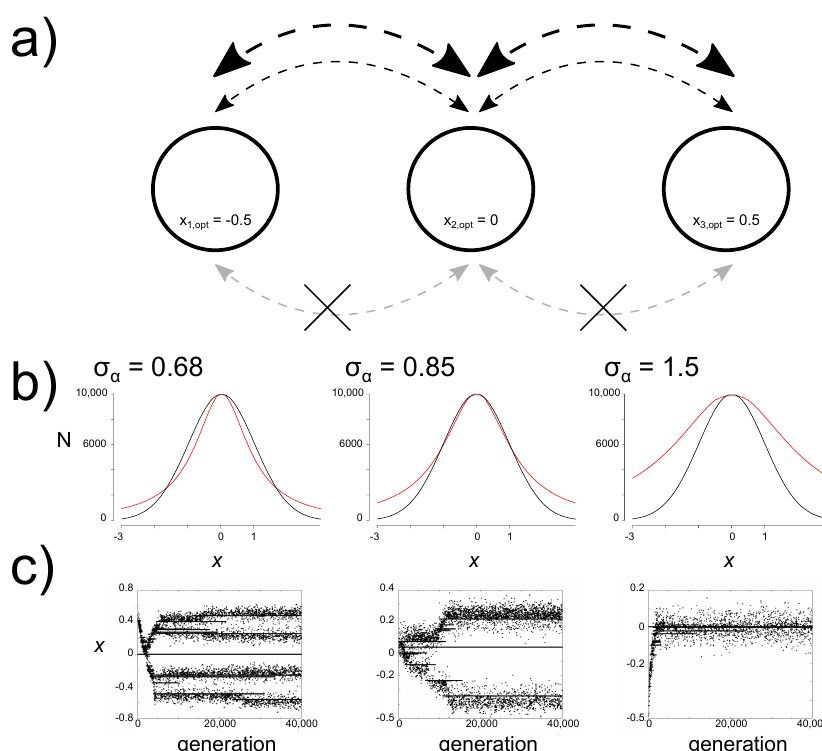
Figure 1. Model of metacommunity eco-evolutionary dynamics for species that compete for resources in a changing environment. ( a ) Communities inhabit a three-patch landscape with sites that vary in their resource distribution (which yields a distribution of carrying capacities centered around a maximum value with an optimal trait value x opt ) and are connected at three levels of dispersal ( d = 0, 0.01, 0.1 are the grey, thin black, and thick black lines respectively). ( b ) Simulations in the metacommunity were conducted using three di ff erent values for competition strength ( σ α = 0.68, 0.85, 1.5). Resident communities for the simulations were generated from modeling long-term coevolution in each patch (no dispersal) in a constant environment. The communities that emerge depend on the relationships between two functions that depend on a phenotype x . The competition function C ( x ) (red line, Equation (3)) depends on the di ff erence in trait values between two populations, with a standard deviation σ α . The carrying capacity function K ( x ) (black line, Equation (1)) depends on the distance of a population’s trait from the local environmental optimum, can be interpreted as di ff erent resources that species can utilize at various e ffi ciencies, and is a distribution with a standard deviation σ K (equal to 1 in simulations). ( c ) The evolutionary history of a set of initial communities used in the simulation are shown. Species can coexist in a stable competitive hierarchy that evolves from a single initial population using a stochastic simulation of adaptive dynamics. In the plot, points represent trait values for all populations present at generation t (i.e., at least one individual exists with that trait value, population size is not represented), and a horizontal line at the optimal trait value is shown. The number of species (all unique populations in existence after 10 6 generations) and the number of distinct cluster of phenotypes are determined by the ratio of the niche width to the width of the resource distribution ( σ α / σ K ). An initial mutant population can evolve into multiple stable clusters when σ α / σ K < 1 (corresponding to σ α = 0.68 and 0.85 in this model), as a region of trait space exists where new mutants with trait values that di ff er from the local optimum still have a carrying capacity that exceeds the impact of competition (where the black line is above the red line). When σ α / σ K > 1 ( σ α = 1.5 in this model), a single population is maintained with a trait value at the local optimum. In these communities, x 0 = 0.3602, − 0.4795, and − 0.4335 for σ α = 0.68, 0.85, and 1.5,